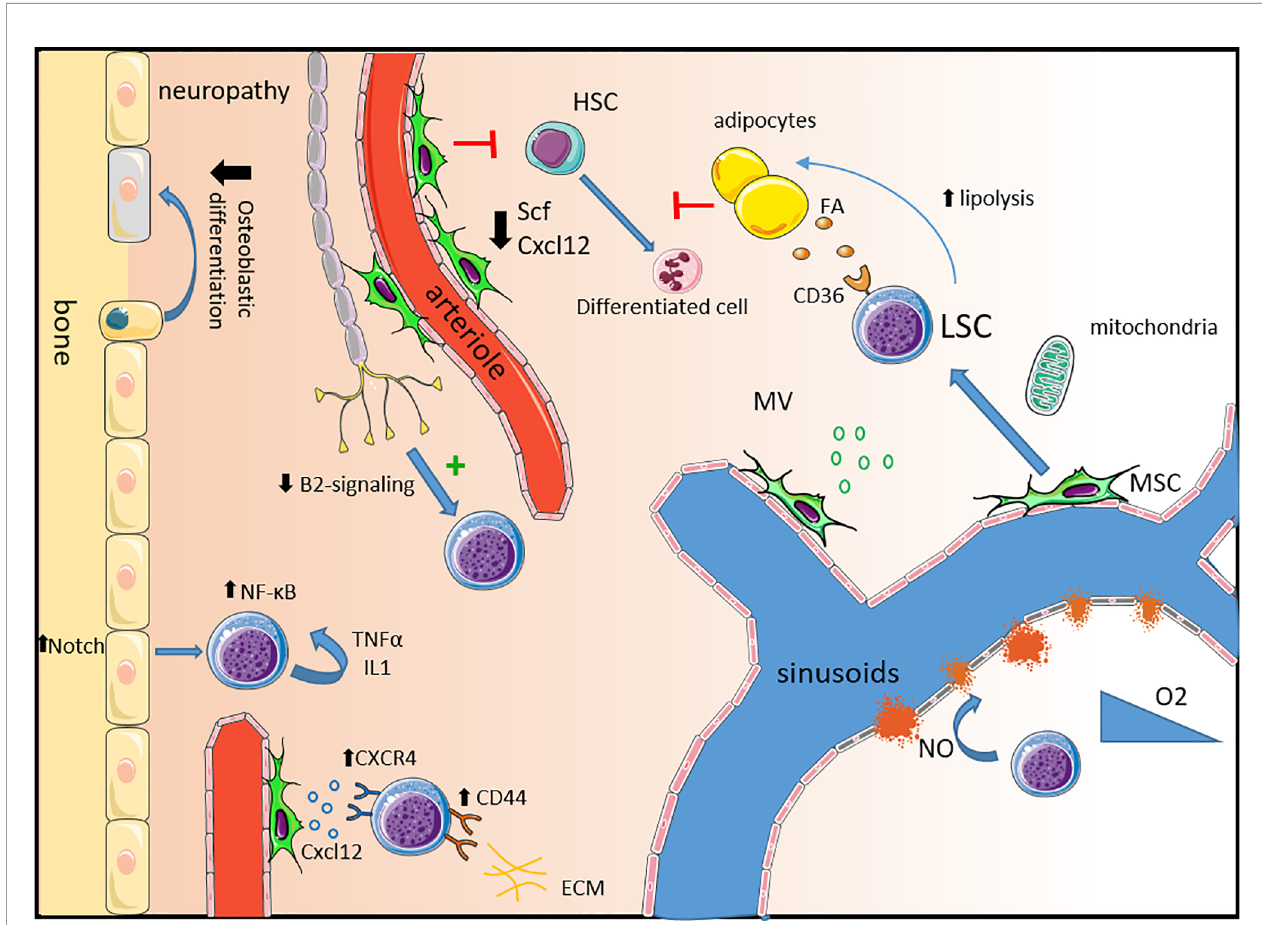
FIGURE 1 | Remodeling of the healthy niche into a permissive leukemic niche. Neuropathy: Leukemic progression is associated with sympathetic neuropathy. Loss of b 2-adrenergic signaling directly promotes leukemic progression and triggers the expansion of MSCs primed for osteoblastic differentiation but with a defect in terminal maturation leading to a reduction in mineralized trabecular bone. Mesenchymal stem cells : In leukemia, MSCs are dysfunctional expressing lower levels of key healthy HSC niche factors such as Scf and Cxcl12 impairing healthy hematopoiesis. LSCs express high levels of the CXCL12 receptor CXCR4 and other adhesion molecules such as CD44 and VLA-4 to usurp the adhesion mechanisms of healthy HSCs. MSC also contribute to LSC survival by the production of microvesicules and via mitochondria transfer, providing energy support. Alteration of the vascular niche: The expression of VEGF in the leukemic niche induces an increase in vascular density and the production of NO by endothelial cells increases vascular leakiness contributing to hypoxia. In leukemia, endosteal blood vessels are more disrupted than the central bone marrow ones. Adipocytes: Leukemic cells support their own metabolism and survival by stimulating lipolysis which fuels fatty acid oxidation in chemotherapy resistant LSCs expressing the fatty acid transporter CD36. In fl ammatory niche : Activation of Notch signaling in osteolineage cells leads to the activation of the NF- k B pathway in leukemic cells supporting their survival and proliferation. An autocrine secretion of pro-in fl ammatory molecules like IL-1 and TNF- a also activates the NF- k B pathway. HSC, hematopoietic cells; SCF, stem cell factor; FA, fatty acid; LSC, leukemic stem cell; MSC, mesenchymal stem cell; MV, microvesicule; NO, nitric oxide; ECM, extracellular